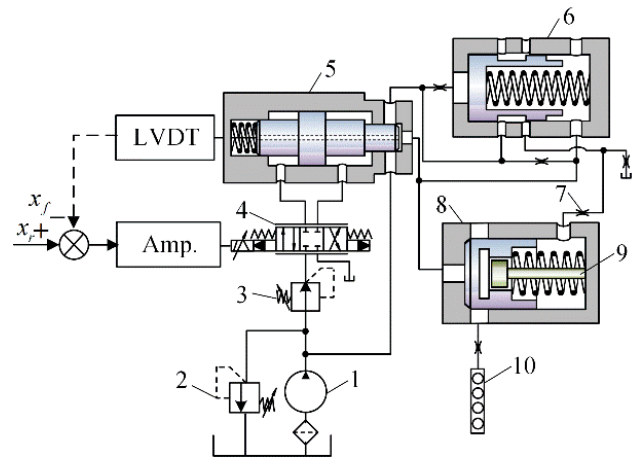
Figure 3. Metering-based fuel flowrate control system: (1) Fuel pump, (2) safety valve, (3) pressure reducing valve, (4) servo valve, (5) metering valve, (6) directed constant pressure difference valve, (7) dynamic damping orifice, (8) main valve, (9) damping piston, (10) combustor.